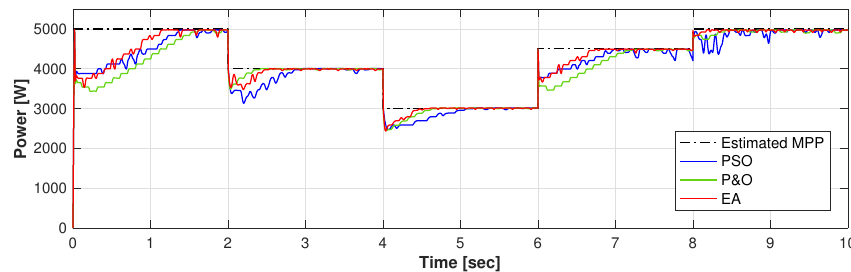
Figure 19. Power harvested through time, regarding high power simulation.